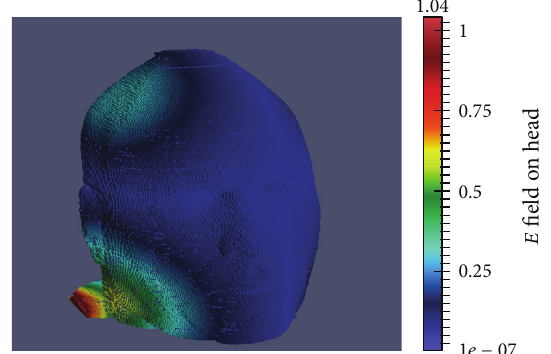
Figure 7: The total electric field distribution on head surface.